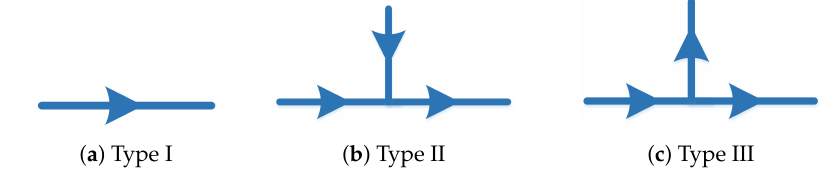
Figure 2. Power flow subgraph of DISO converters